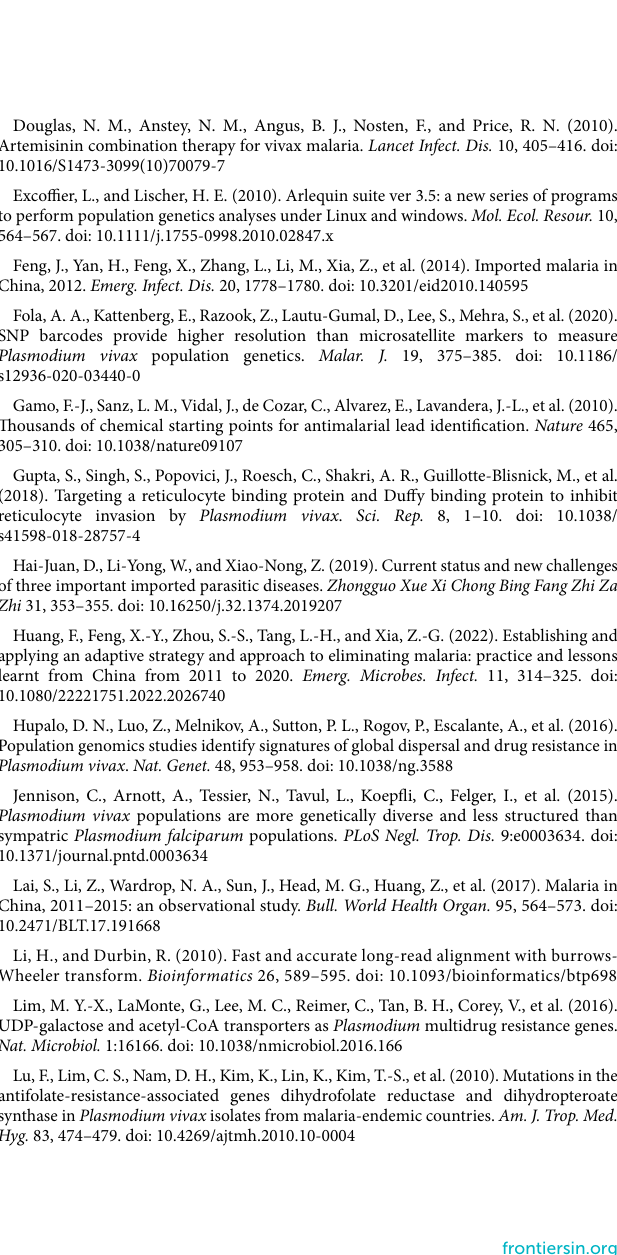
SUPPLEMENTARY FIGURE S2 ADMIXTURE structure in China inland samples relative to the reference mapped with the P01 genome. The China* samples are also downloaded from Pearson et al.’s study, which was collected from Yunnan, China in 2011. The ADMIXTURE bar plot illustrates the population structure within and among populations at an optimized cluster value of K =